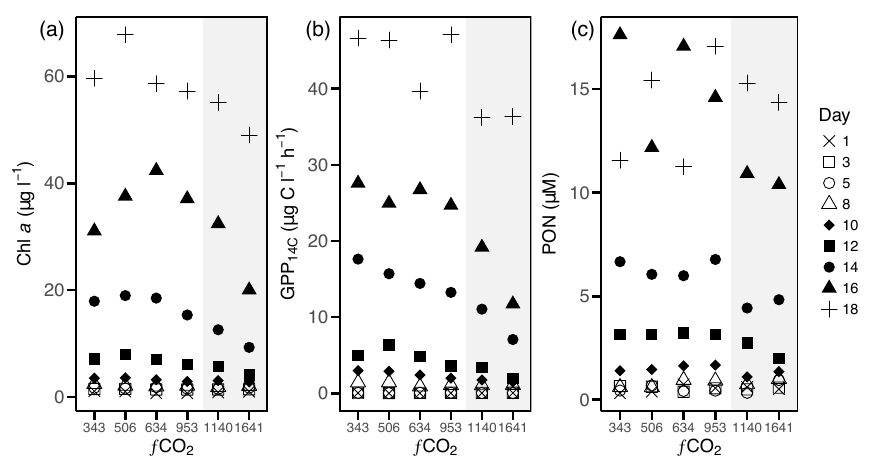
Figure 10. Temporal trends of (a) Chl a , (b) 14 C-derived gross primary production (GPP 14 against CO 2 treatment. Grey shading indicates CO 2 treatments ≥